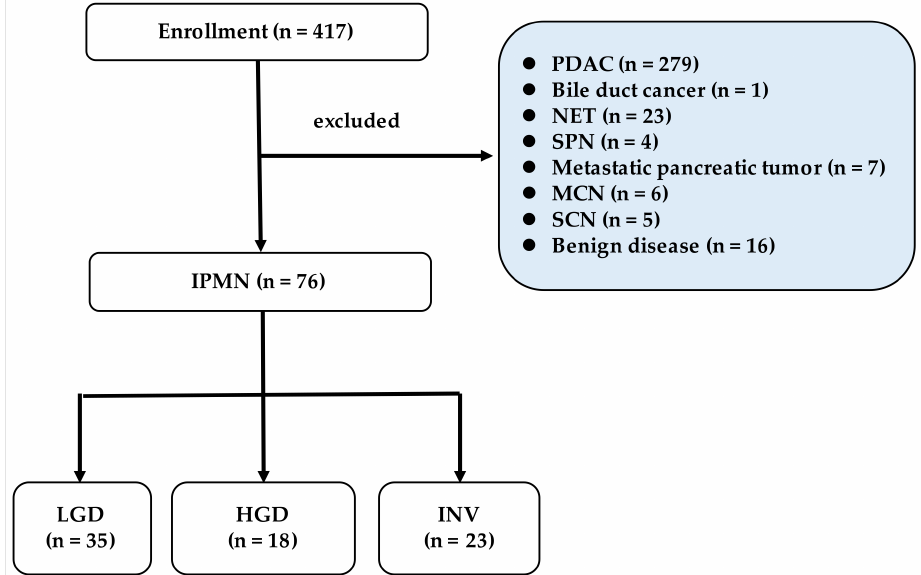
Figure 1. Diagram illustrating the study design. PDAC: pancreatic ductal adenocarcinoma, NET: neuroendocrine tumor, SPN: solid-pseudopapillary neoplasm, MCN: mucinous cystic neoplasm, SCN: serous cystic neoplasm, IPMN: intraductal mucinous neoplasm, LGD: low-grade dysplasia, HGD: high-grade dysplasia, INV: invasive